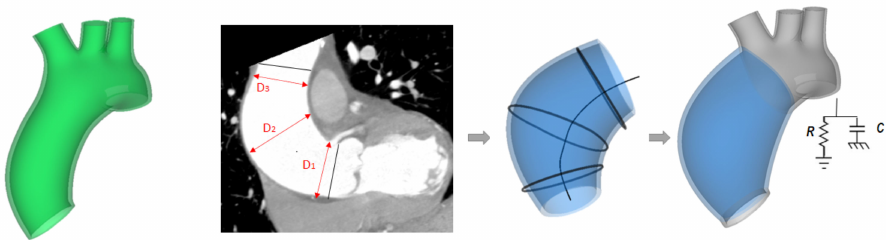
Figure 1. Workflow showing the modification of the original LHHM to account for the ATAA; the green model ( left ) shows the original aortic model; measurements of ATAA diameter from CT images ( middle-left ); ATAA model showing the centerline and curve used for the loft protrusion surface ( middle-right ); ATAA model showing the coupling with the lumped-parameter model as boundary condition ( right